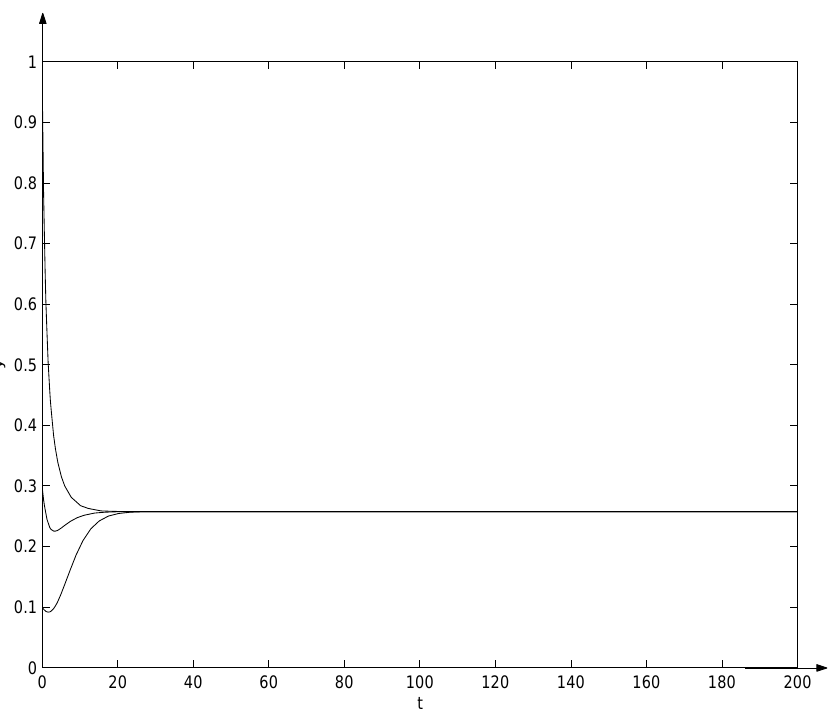
Figure 3. Evolutions y ( t ) of system